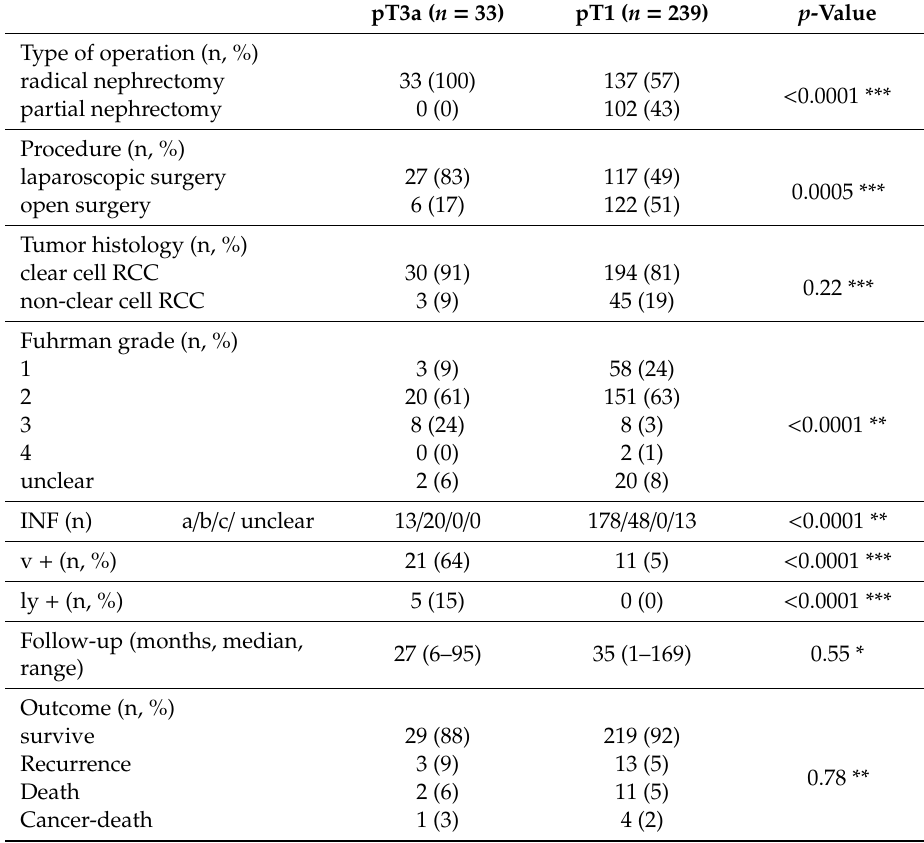
Table 5. The di ff erences of the tumor characteristics and postoperative parameters between the pT3a and pT1